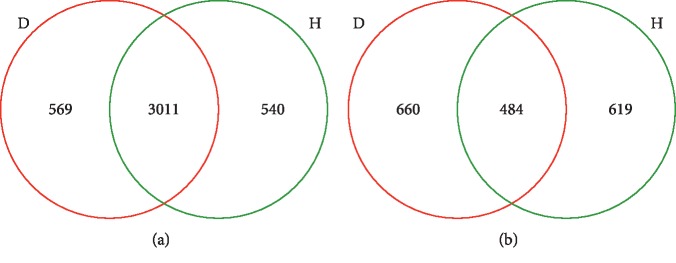
Venn diagram for bacterial (a) and fungal (b) communities. Venn diagram showing the number of shared and unique operational taxonomic units (≥97% similarity) among the rhizosphere soils of healthy and rusty root-affected Panax ginseng. H: healthy plants; D: diseased plants.